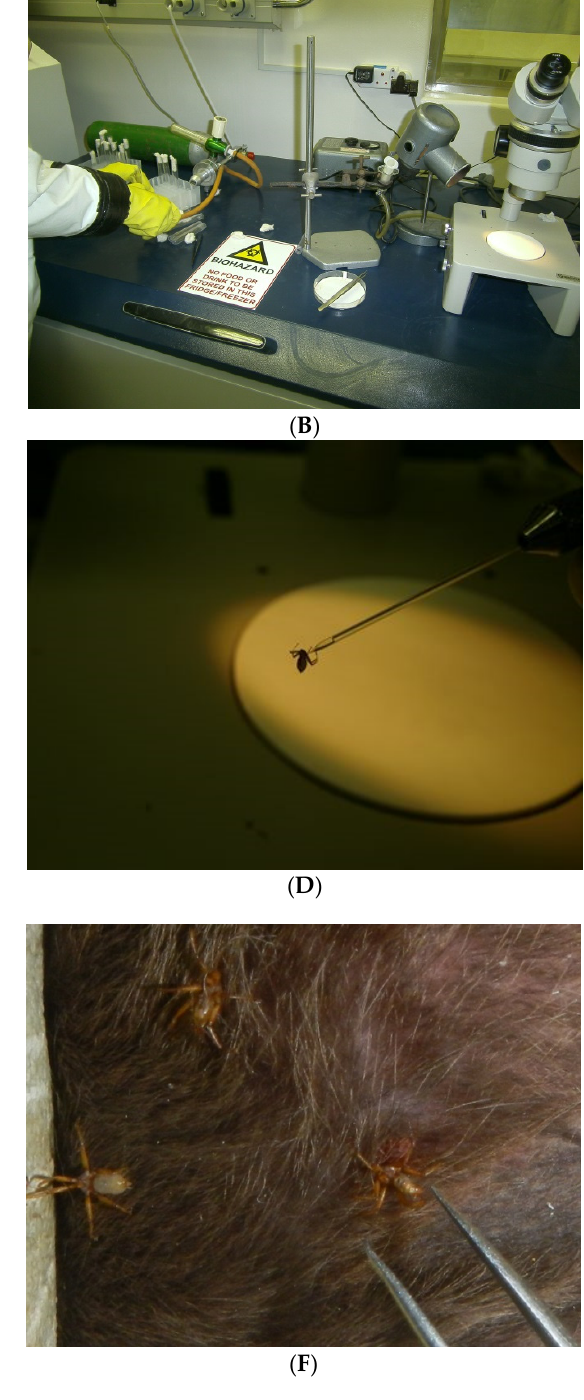
Figure 8. Bat flies kept in plastic tubes for anaesthesia ( A ); Stereomicroscope with light source, inoculation equipment, and CO 2 cylinder ( B ). Anaesthesia of flies with CO 2 ( C ); Intra ‐ coelomic inoculation of flies with Marburg virus (MARV) under stereomicroscope ( D ); Inoculated female bat fly in a glass tube recovering from anaesthesia and inoculation ( E ). Release of inoculated flies on MARV ‐ seronegative bats ( F ).